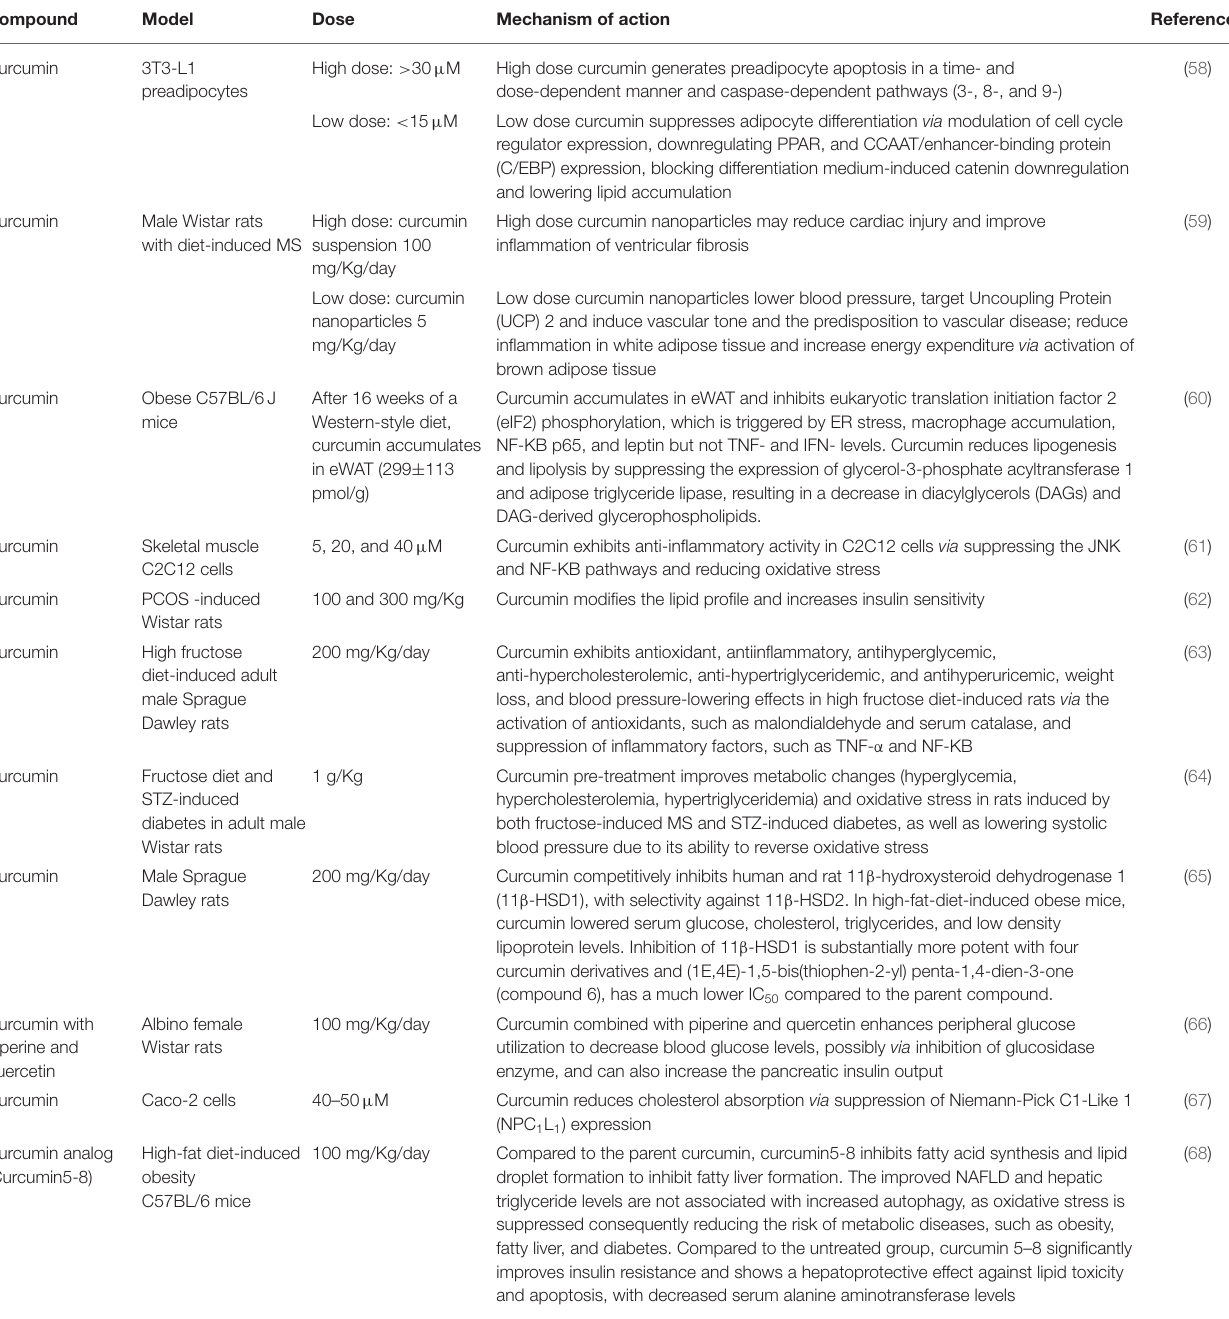
TABLE 1 | Summary of in vitro or animal models studies on the effect of curcumin and its analogs on the individual parameter of MS.